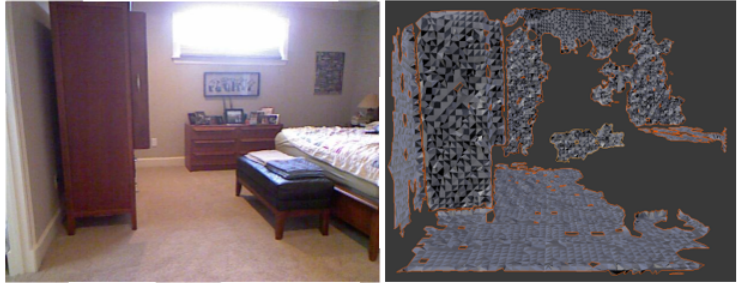
Figure 9. An example of plane reconstruction for an image from NYUv2 dataset [38].